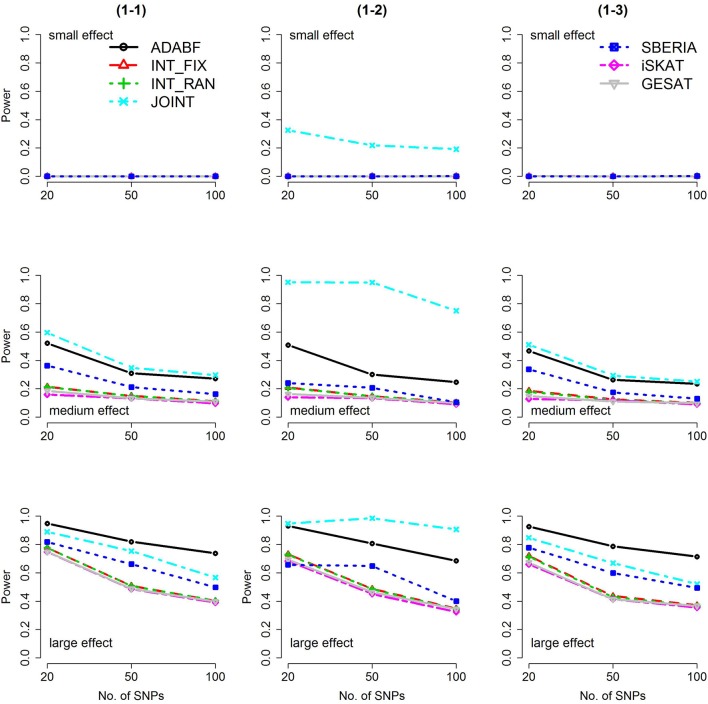
Power of the seven tests for binary traits (1 SNP × E). The x-axis represents the number of SNPs in the gene, whereas the y-axis depicts the power at the nominal significance level α = 2.5 × 10−6. From the top row to the bottom row, the magnitudes of SNP main effects and SNP × E interaction effects were evaluated at three levels: small, medium, and large, respectively.